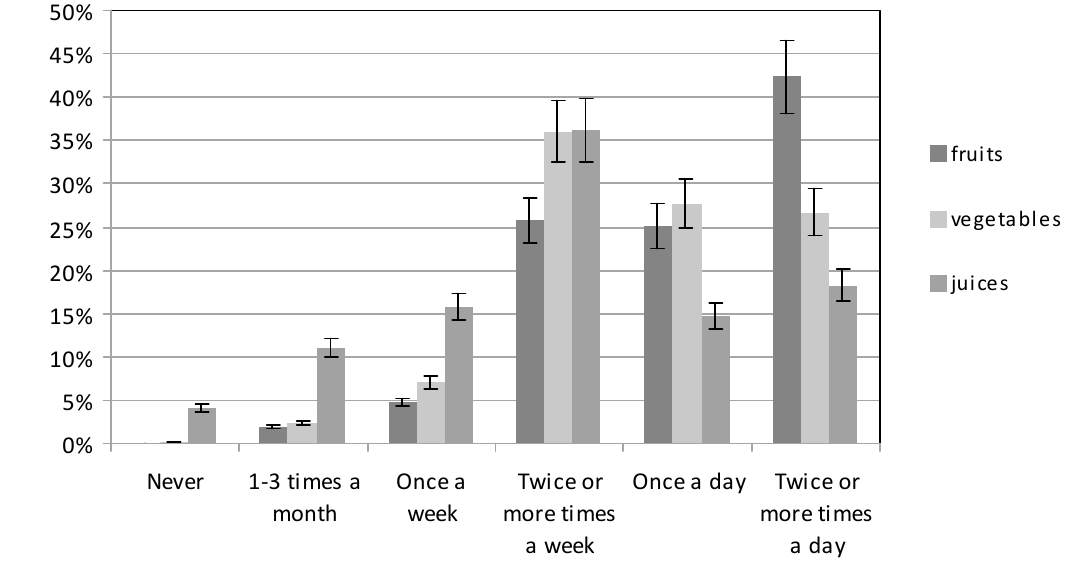
Figure 3. The consumption of fruit, vegetables, and juices by participants.